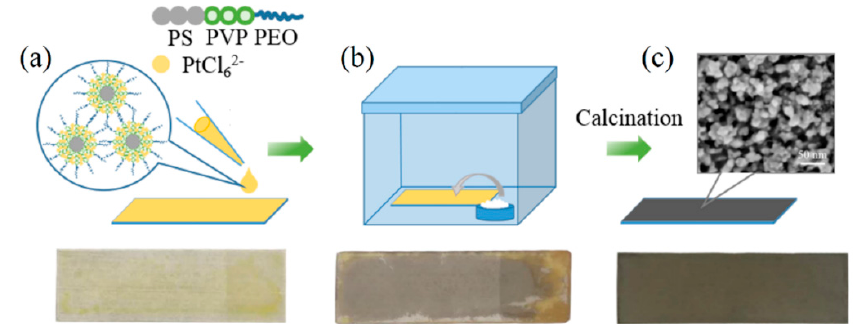
Figure 2. Schematic illustration of the preparation procedures of mesoporous Pt particles. ( a ) Polymeric micelle of PS 192 - b -P2VP 143 - b -PEO 613 reacts with negatively charged PtCl 62 − to form composite micelles, and the solvent on the glass substrate is evaporated. ( b ) Pt deposition is stimulated by the vapor infiltration of the reducing agent DMAB. ( c ) After removal of the template through calcination, black mesoporous Pt catalyst is obtained.